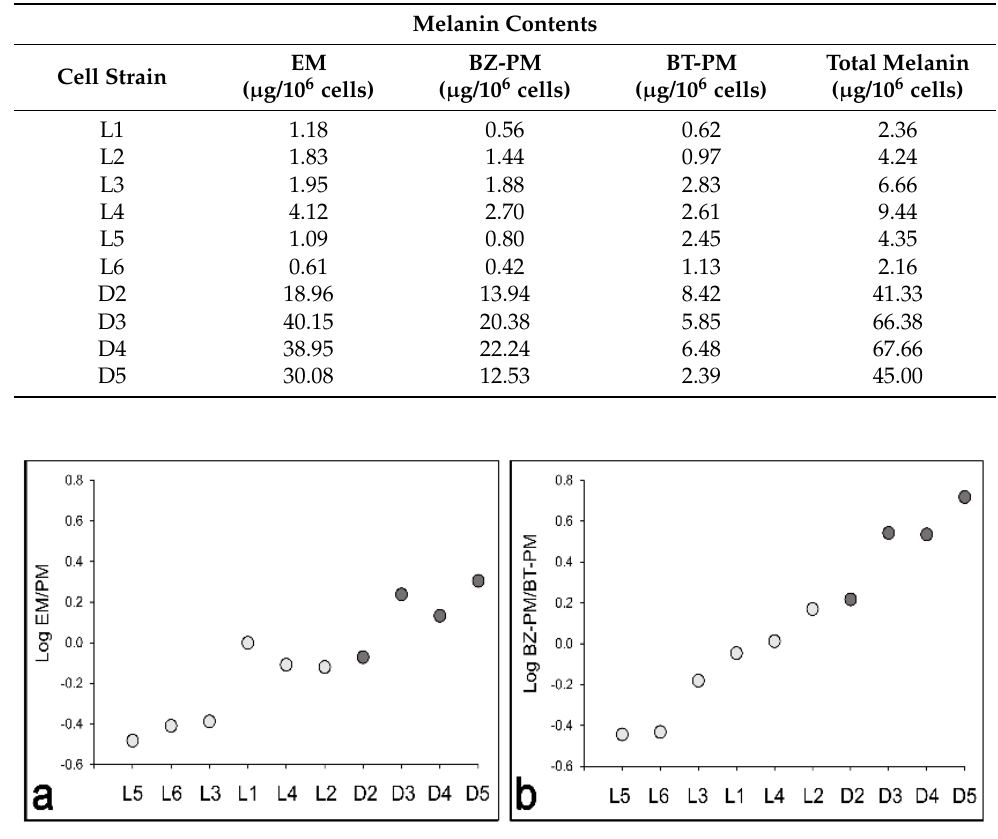
Figure 1. Comparison of the eumelanin (EM)-to-pheomelanin (PM) ratio in ( a ) and the ratio of benzothiazole-pheomelanin (BZ − PM) to benzothiazine-pheomelanin (BT-PM) in ( b ) in L versus D melanocyte cultures.